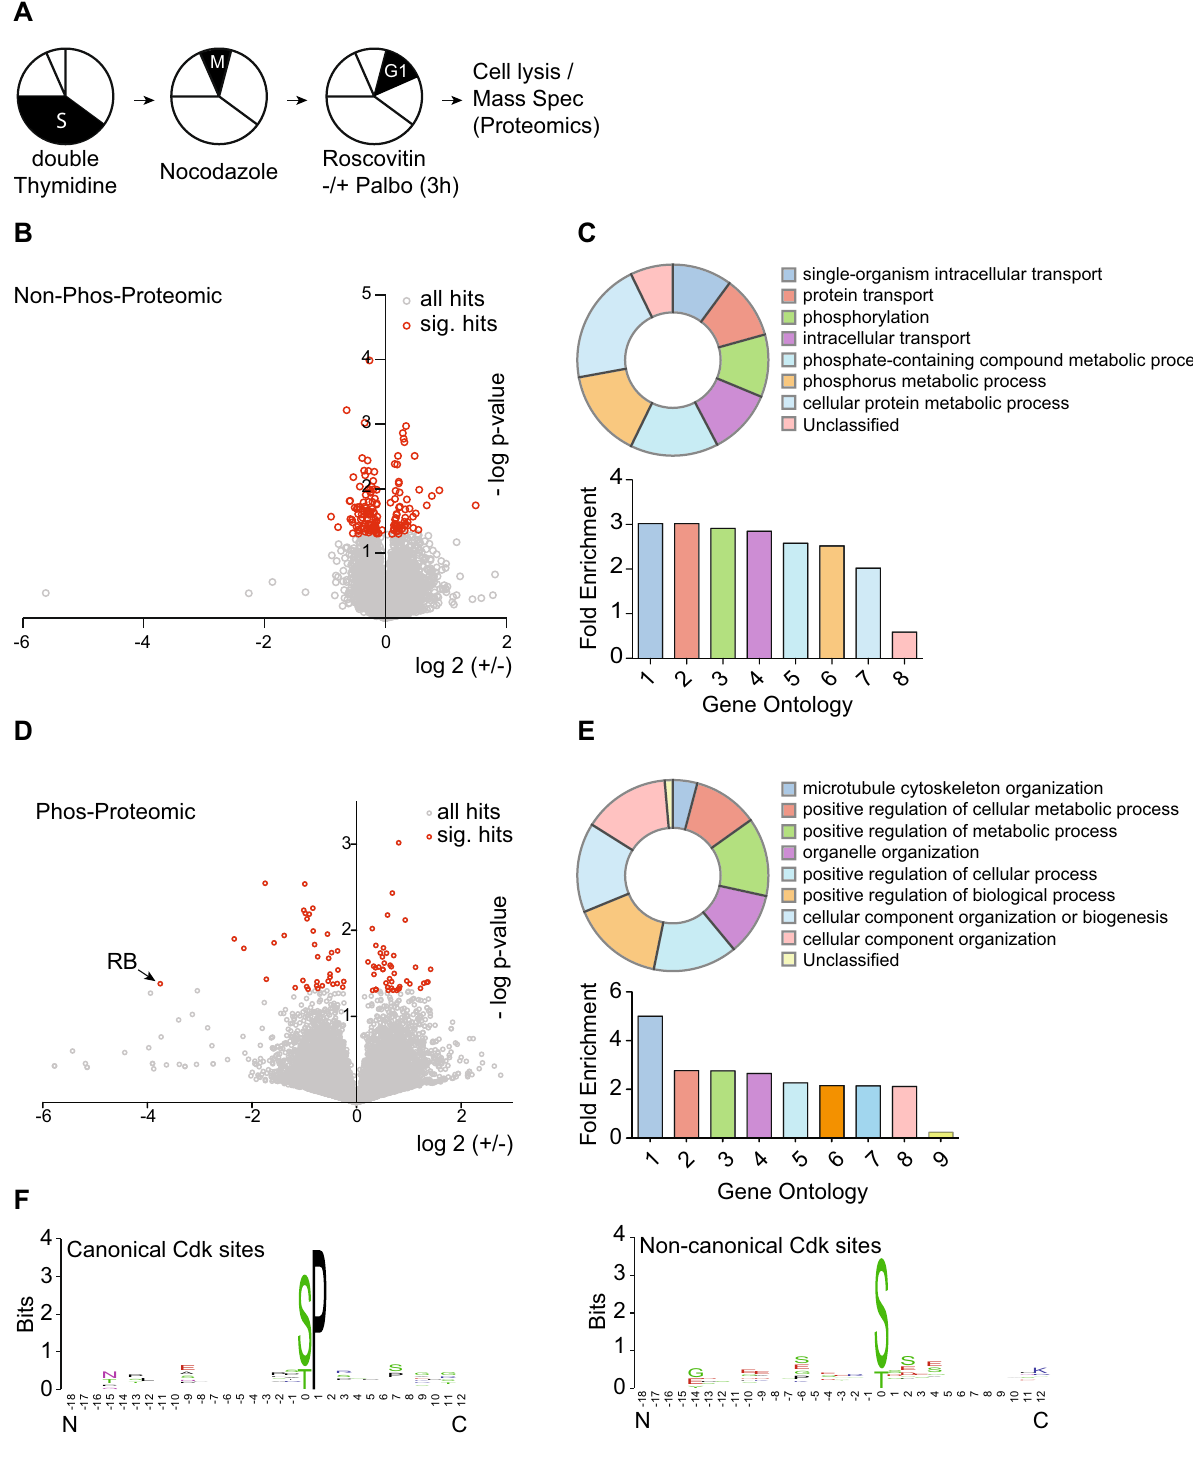
Figure 5. Proteomic- and phosphor-proteomic signature of early G1 cells treated with Palbociclib. ( A ) Scheme visualizing the experimental set up of this figure. In short: cells were S phase arrested by double Thymidine blockage, released into Nocodazole to induce pro-metaphase blockage in mitosis, harvested by mitotic shake-off and subsequently released and re-plated for 1 h before Roscovitine [15 μM] and either DMSO or Palbociclib was added to the cells for 3 h. ( B ) Scatter plot of proteins identified by whole proteomic mass-spectrometry. Note: Proteins undergoing a significant regulation are displayed in red. ( C ) Significant Hits from B were used for Gene-Ontology analysis. Significantly enriched pathways are displayed as their overall contribution (top panel) and their fold enrichment over background (bottom panel). ( D ) Scatter plot of phosphor-peptides identified by mass-spectrometry. Note: Peptides undergoing a significant regulation are displayed in red. ( E ) Significant Hits from D were used for Gene-Ontology analysis. Significantly enriched pathways are displayed as their overall contribution (top panel) and their fold enrichment over background (bottom panel). ( F ) All significant hits from D were used for canonical and non-canonical Cdk consensus site motif